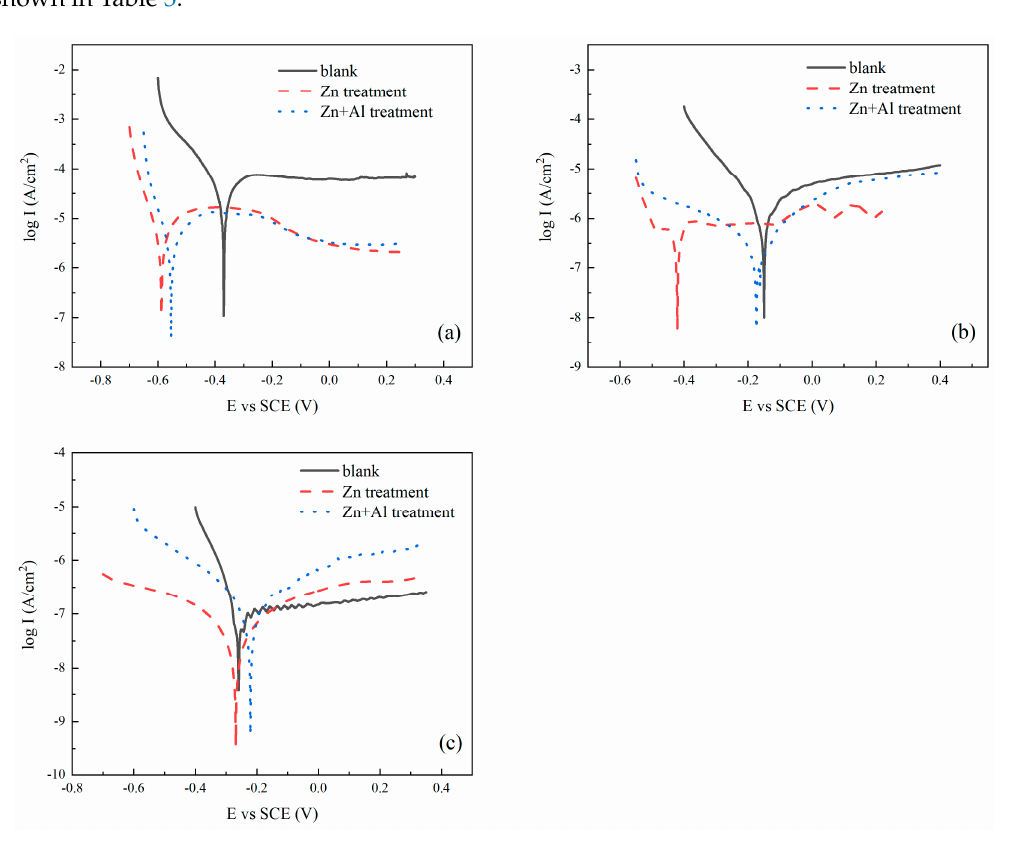
Table 3. The corrosion current (I corr ) and corrosion potential (E corr ) of the passive films formed on A508-3, 304L and In800 with different treatment methods.